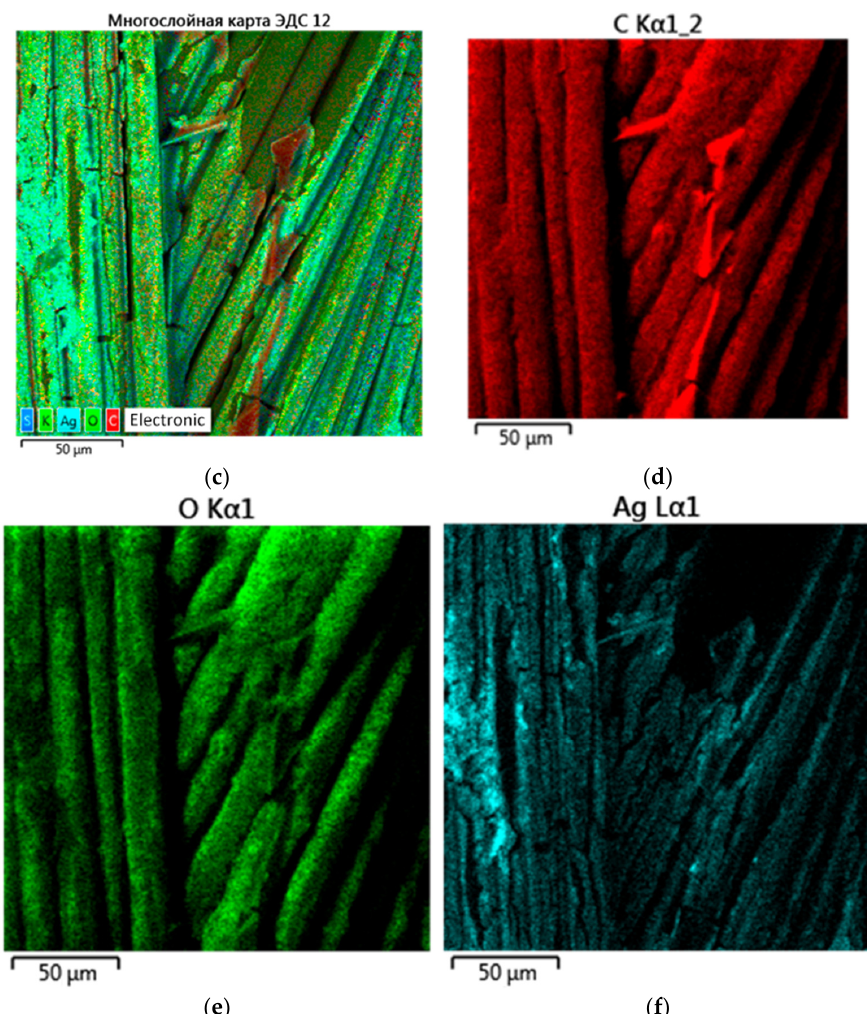
Figure 18. A sample of suture material treated by oxidized Ag NPs: ( a )—SEM micrograph (×500), ( b )—SEM micrograph (×128,000), ( c )—multilayer map of EDS, ( d )—elemental map of EDS (C), ( e )—elemental map of EDS (O) and ( f )—elemental map of EDS (Ag).